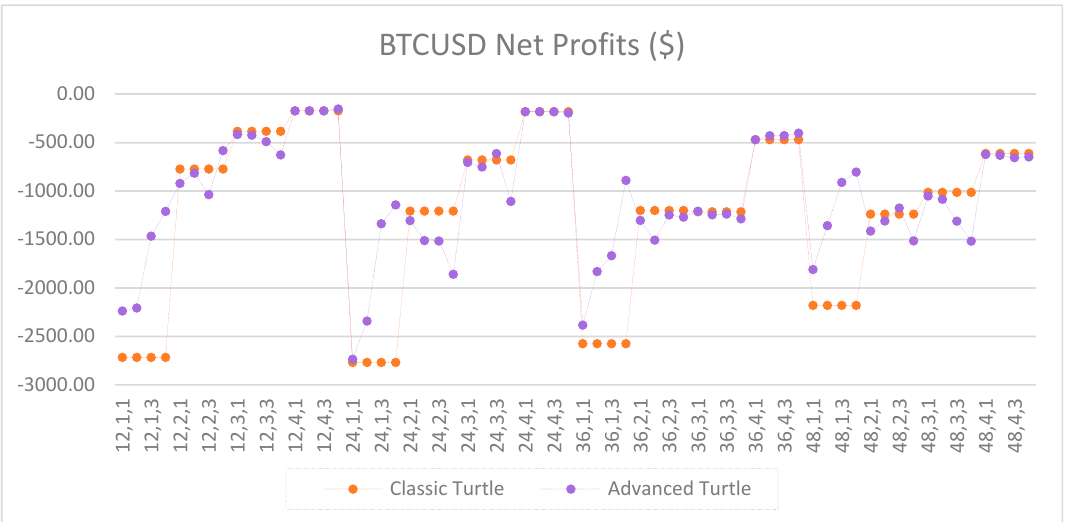
Figure A15. Net profits of BTCUSD between the classic and the advanced Turtle systems for every combination of N, X, Y for the fast parameters (20, 40).